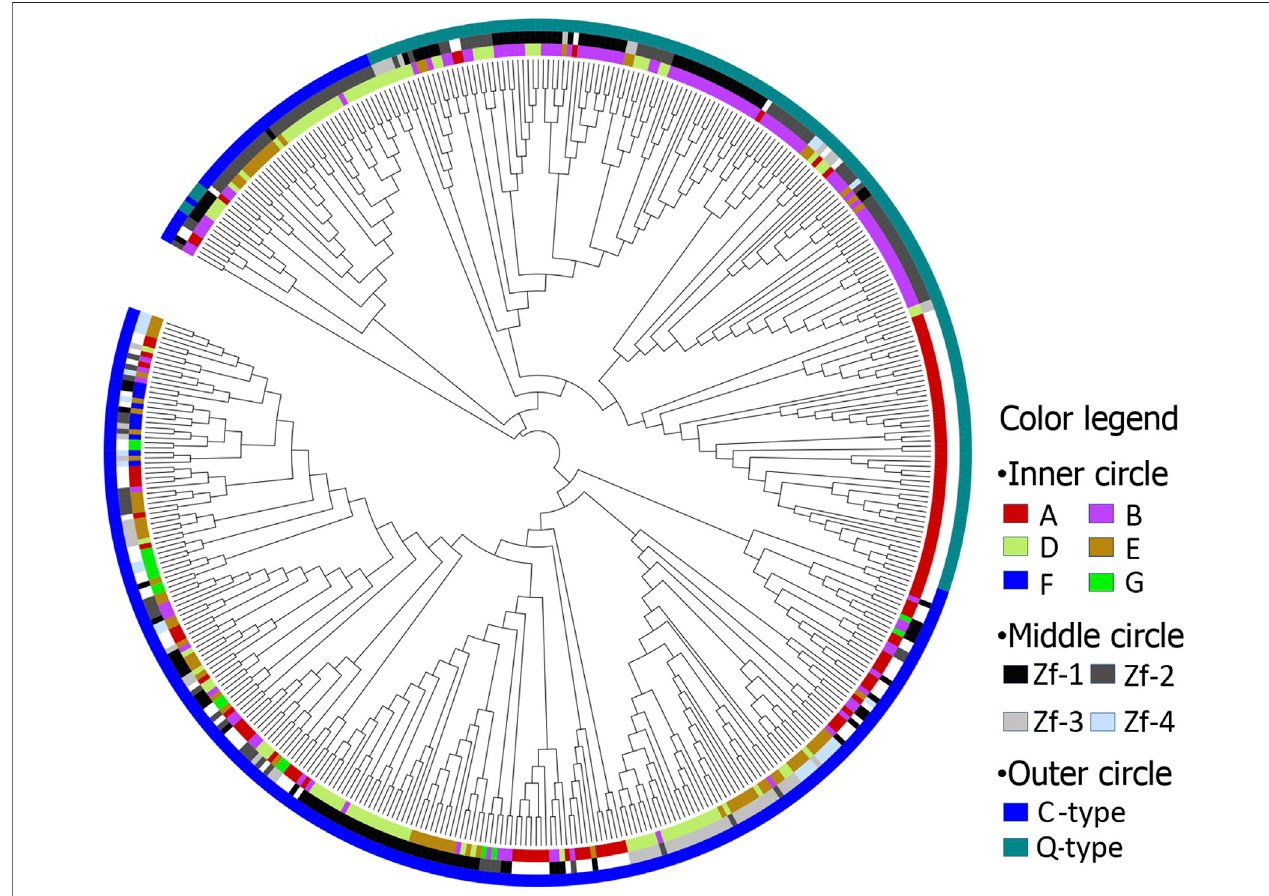
FIGURE1| ThephylogenetictreeofmaizeC2H2-ZFmotif.Innercircle:A,B,D,E,F,andGrepresentsZFmotifsinC2H2-ZFgenes,including1,2,3,4,5,and9ZF motifs, respectively; Middle circle: Zf-1, Zf-2, Zf-3, and Zf-4 represent fi rst, second, third and fourth ZF motifs, respectively; Outer circle: C and Q represents C-type and Q-type ZF motifs,